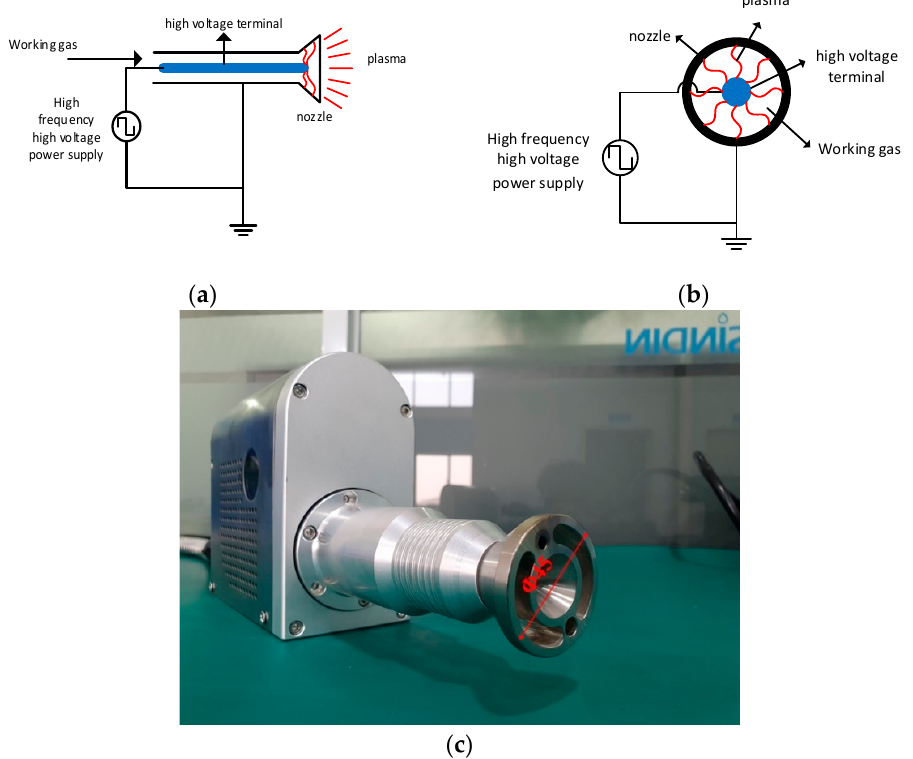
Figure 2. Cross section of plasma torch: ( a ) Lateral section; ( b ) Frontal section; ( c ) Real figure. Plasma torch load is imposed by the working gas, nitrogen, argon, or compressed air.